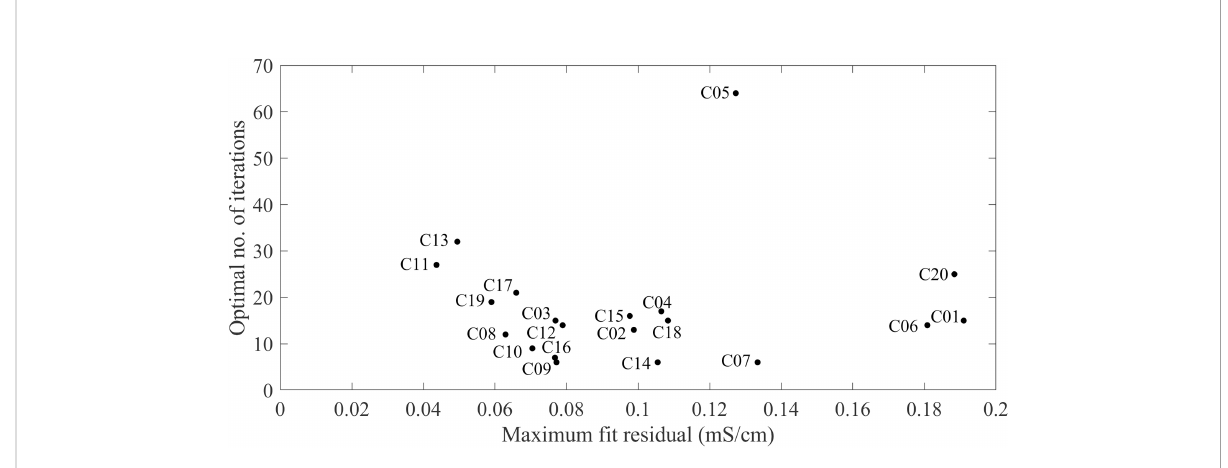
FIGURE 6 Optimal number of iterations and corresponding maximum fi t residuals for cases